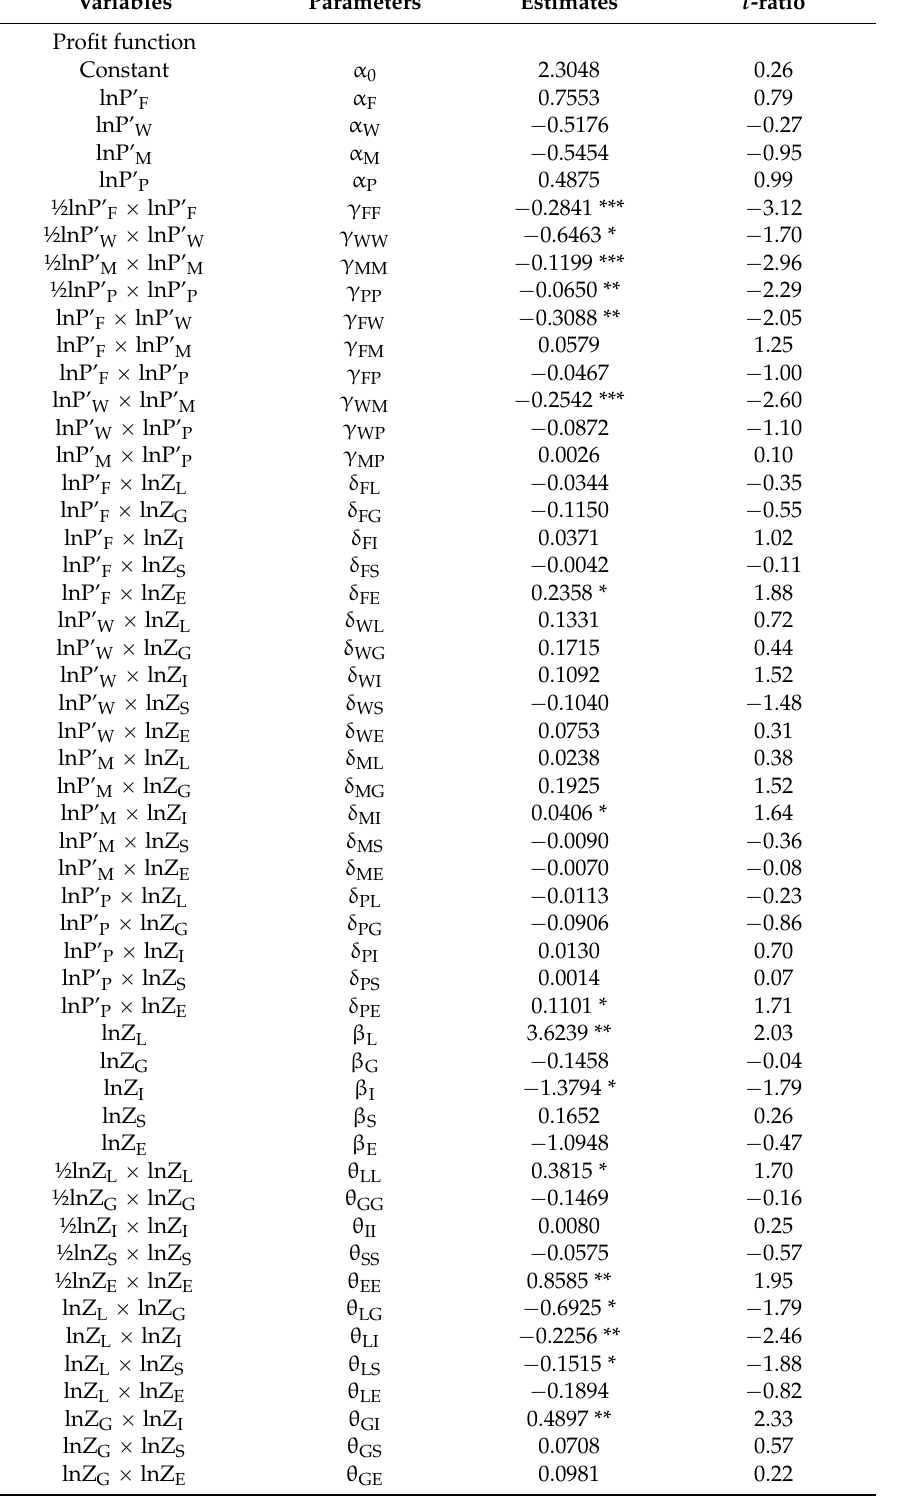
Table 5. Restricted parameter estimates of the translog profit functions along with input share equations of